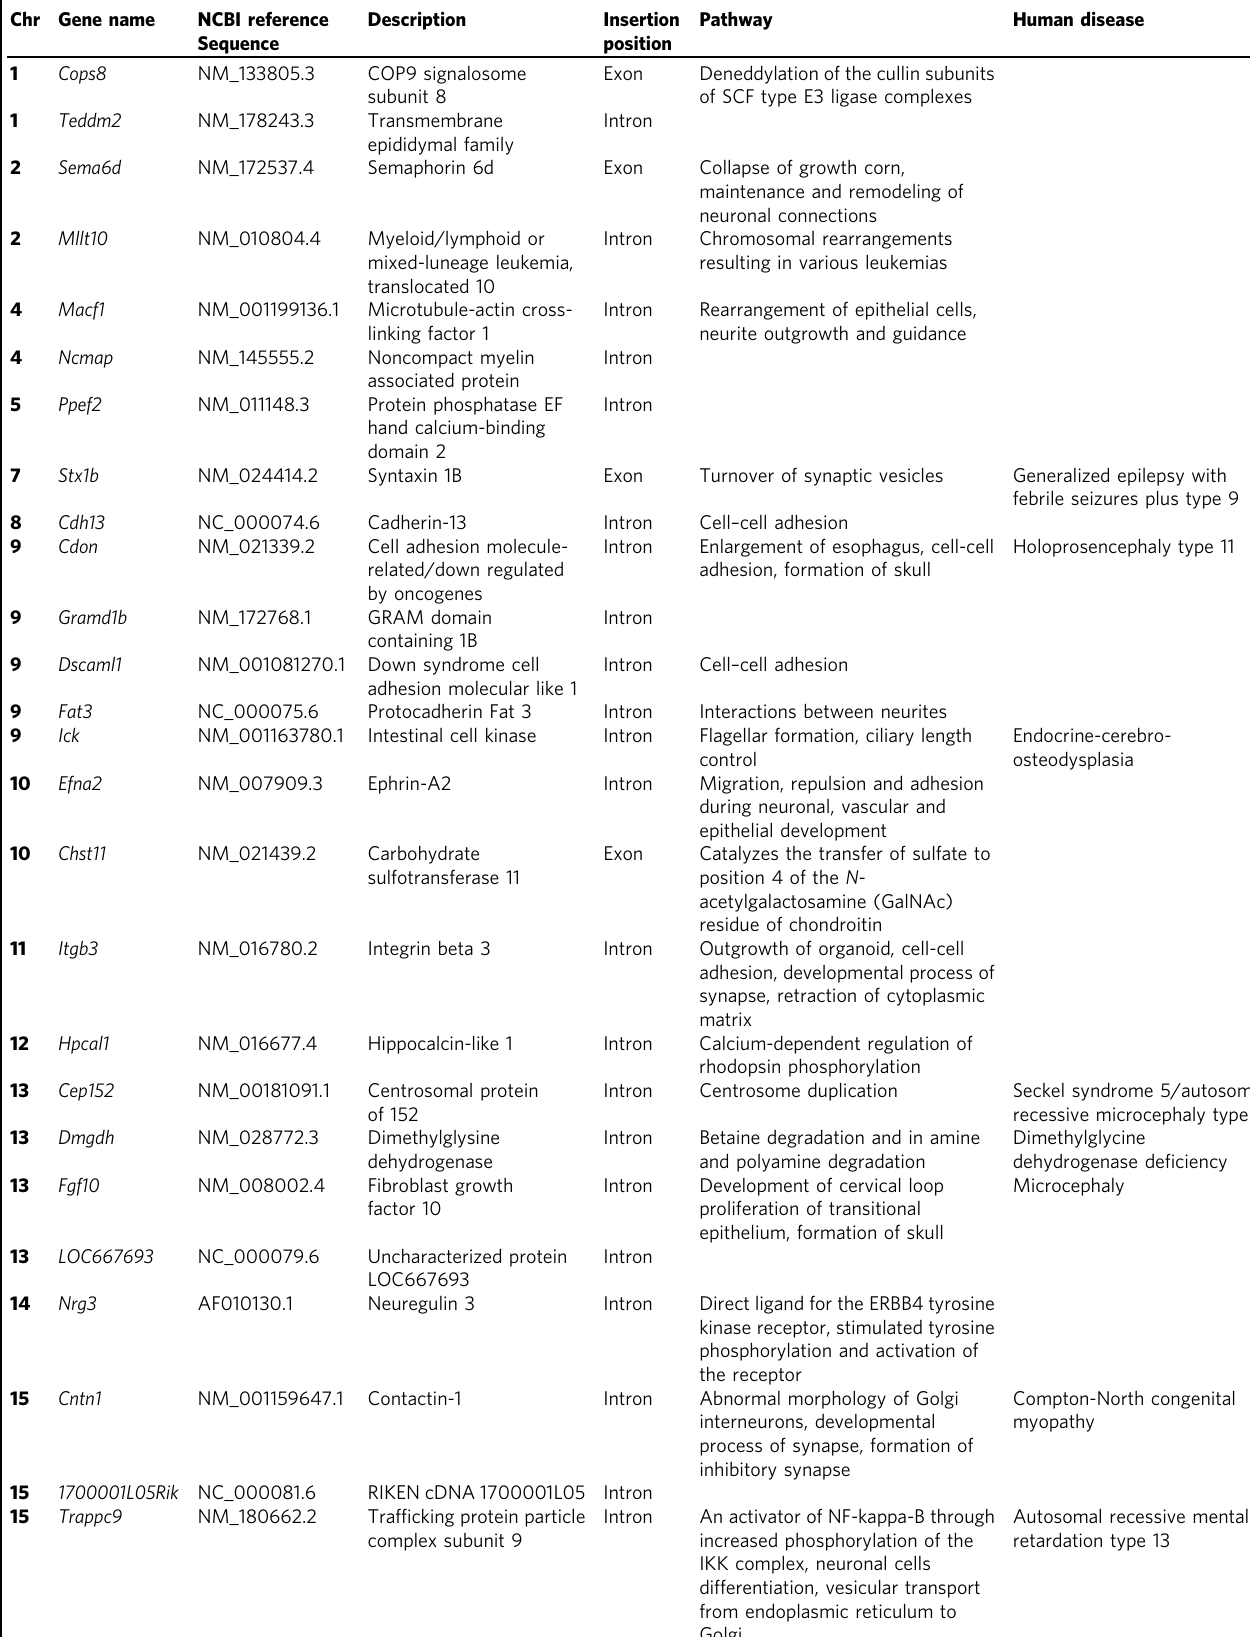
Table 1 Genes identi fi ed from PB-based in vivo genetic screen of cortical